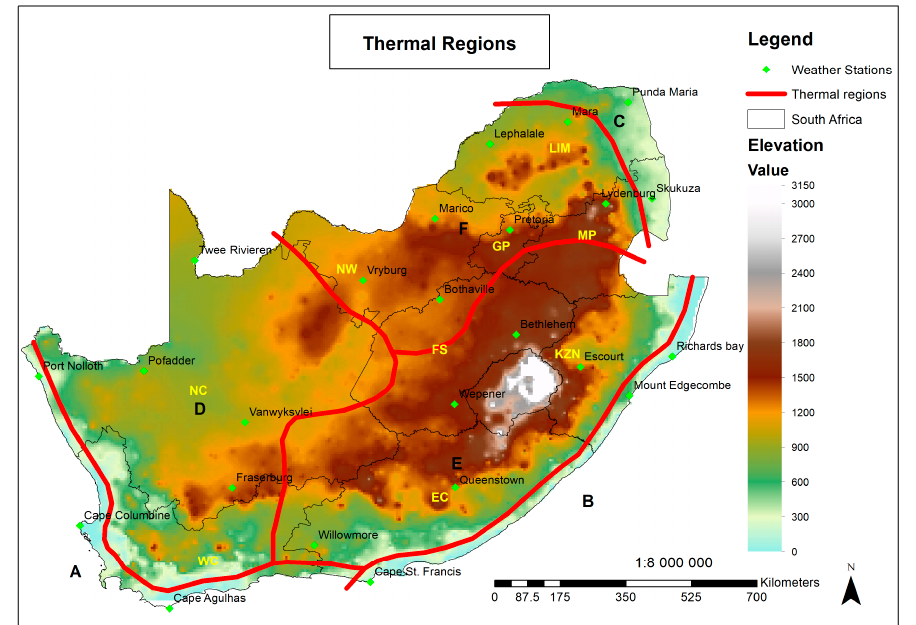
Figure 1. Topographical map of South Africa showing thermal regions and SAWS point station names (in black) with at least 95% data availability from 1981 to 2020 (after [27]). The abbreviations in yellow represent provincial names: Western Cape (WC), Northern Cape (NC), Eastern Cape (EC), Free State (FS), KwaZulu-Natal (KZN), North West (NW), Gauteng (GP), Mpumalanga (MP), and Limpopo (LIM). Table 1. List of relevant ETCCDI indices utilized in this